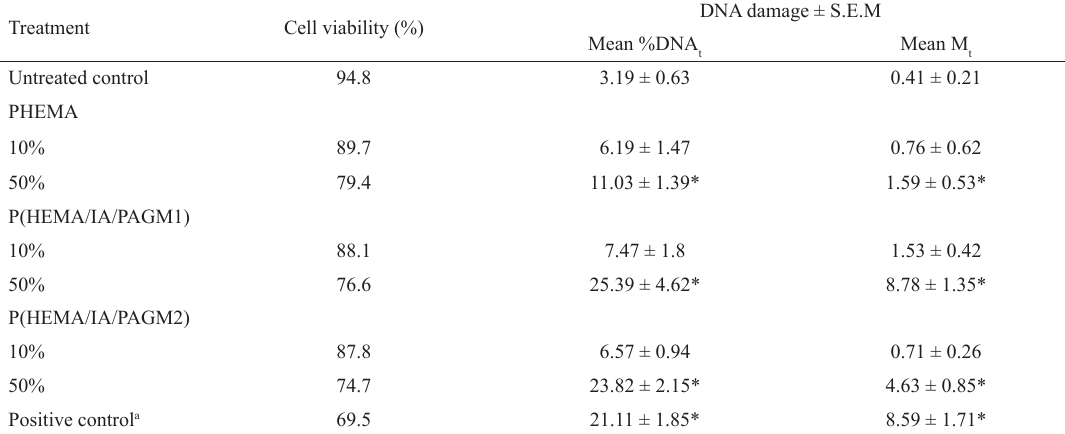
Table 3. Cell viability and Comet assay data for HeLa cells exposed to the extracts of HEMA-based hydrogels for 24 h. Treatment